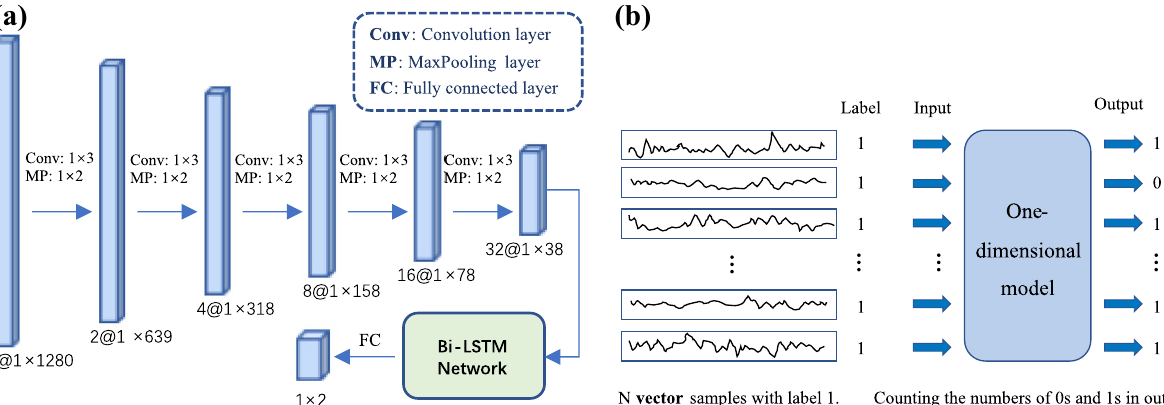
Figure 2. ( a ) One-dimension CNN with a Bi-LSTM network. Conv and MP refers to Convolutional layer and MaxPooling, the following 1 × 3 and 1 × 2 indicate the kernel size, the stride of which is 1 and 2,